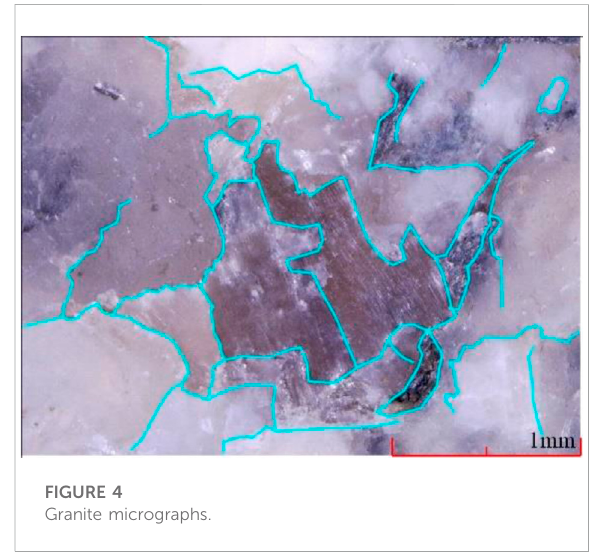
FIGURE 4 Granite micrographs.